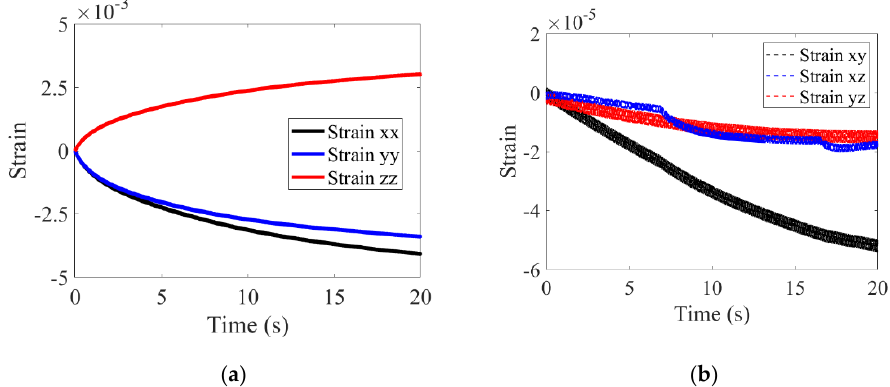
Figure 7. ( a ) The changing of strain items following xx, yy and zz directions with rotating loading, ( b ) the changing of strain items following xy, xz and yz directions with rotating loading.